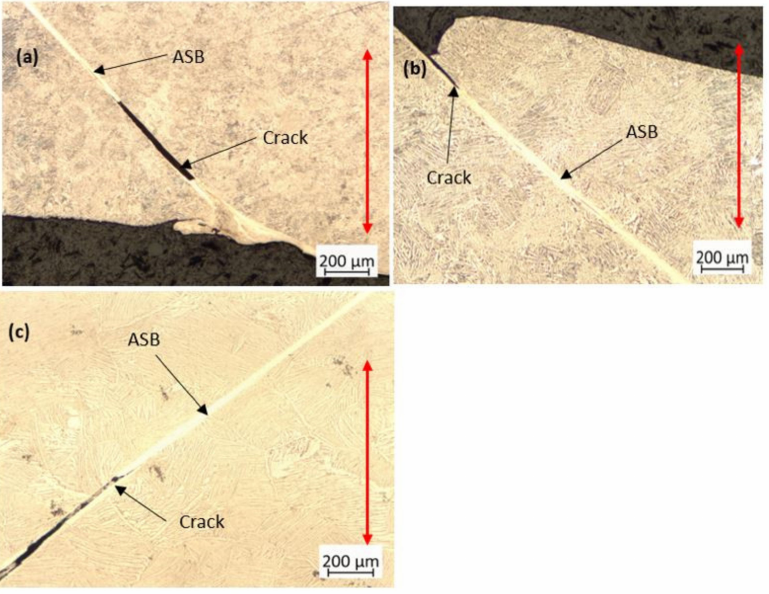
Figure 13. Typical deformation features on cross sections through the surfaces of samples ( a ) C, ( b ) D, and ( c ) E observed under an optical microscope (the red arrows indicate the compression